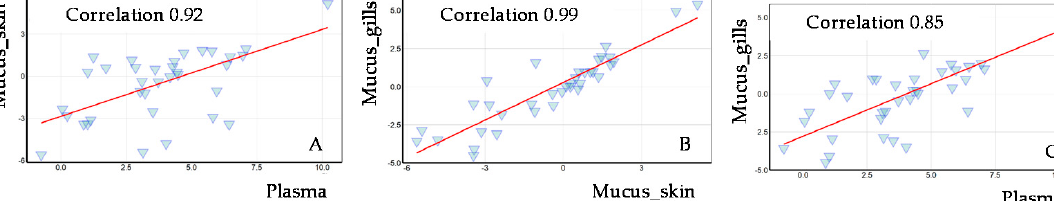
Figure 2. The correlations between concentrations of 36 metabolites that were detected both in plasma and in mucus; ( A ) skin mucus vs. plasma; ( B ) gill mucus vs. skin mucus; ( C ) gill mucus vs. plasma; Pearson’s correlation coefficients were calculated based on normalized concentrations ( µ M); axes are on a logarithmic scale.